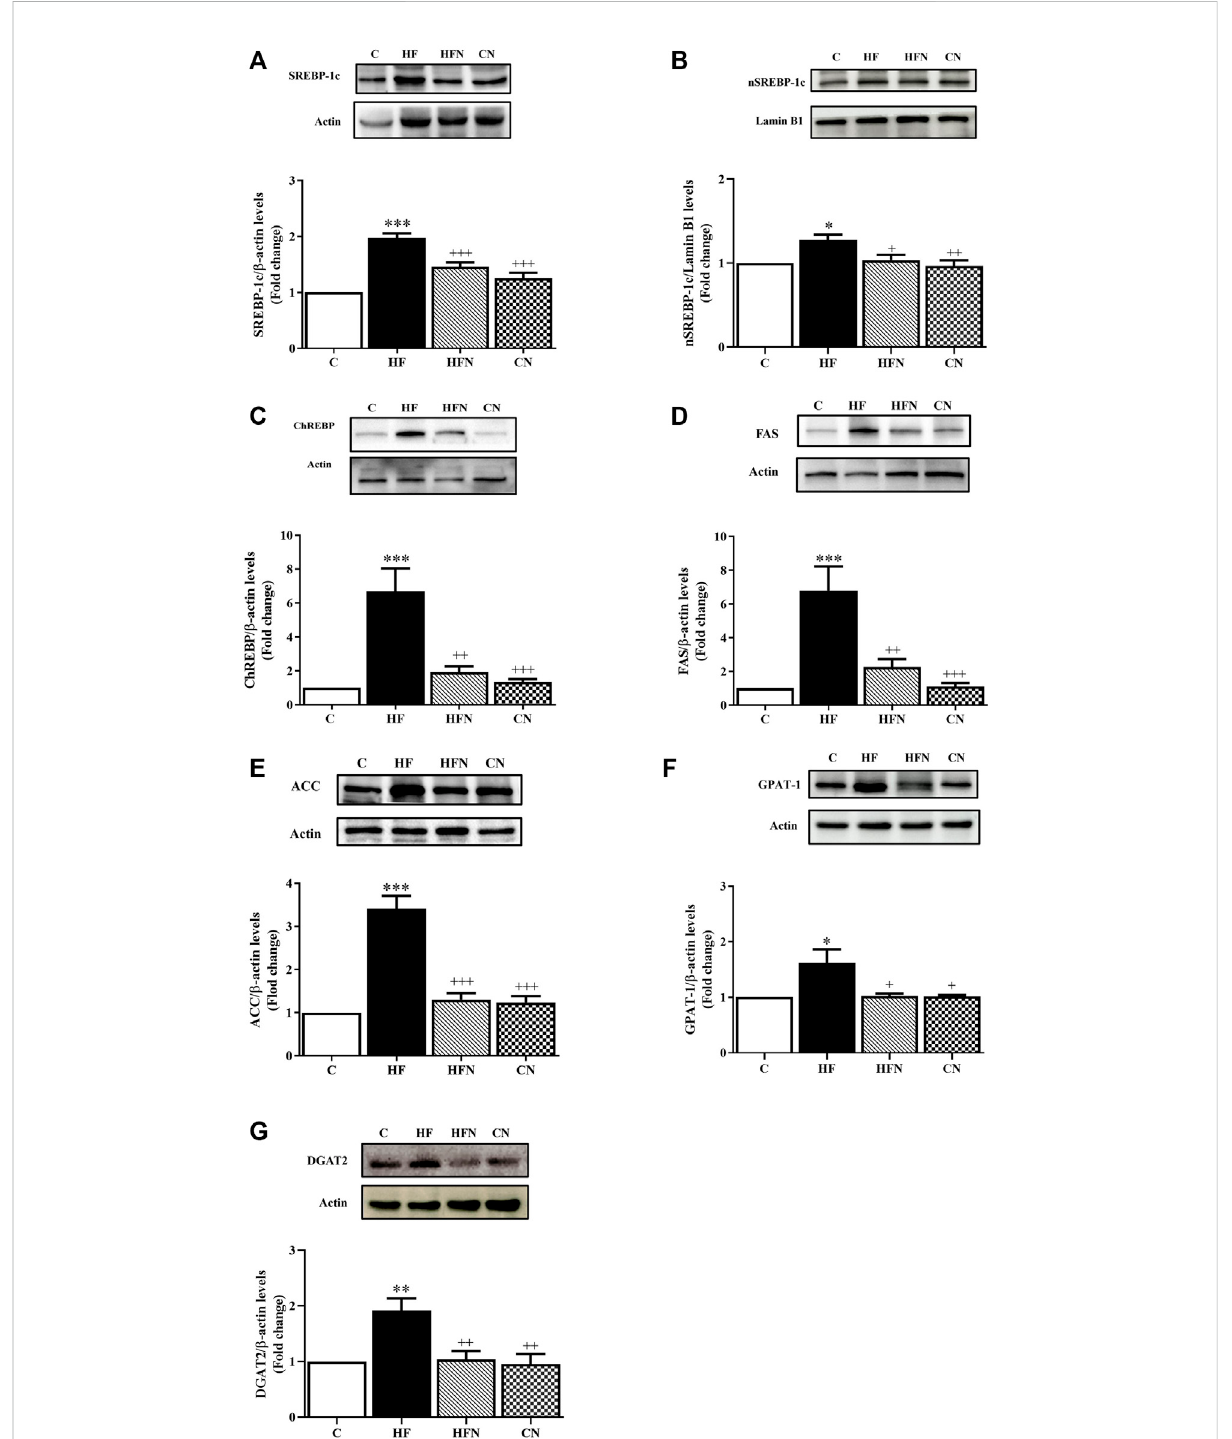
FIGURE 3 The effects of naringin on hepatic lipogenesis. Hepatic expression of (A) sterol regulatory element binding protein-1c (SREBP-1c), (B) nuclear SREBP-1c (nSREBP-1c), (C) carbohydrate response element-binding protein (ChREBP), (D) fatty acid synthase (FAS), (E) acetyl CoA carboxylase (ACC), (F) glycerol-3-phosphate acyltransferase 1 (GPAT-1) and (G) diacylglycerol/acyl-CoA acyltransferase-2 (DGAT2) in control rats (C), fructose- fedrats(HF),fructose-fedratstreatedwithnaringinat100 mg/kg(HFN)andcontrolratstreatedwithnaringinat100 mg/kg(CN).Theresultsare presentedasthemean±standarderrorofthemean(n=5pergroup).* p < 0.05,** p < 0.01,*** p < 0.001comparedwiththecontrolgroup; + p < 0.05, ++ p < 0.01, +++ p < 0.001 compared with the HF